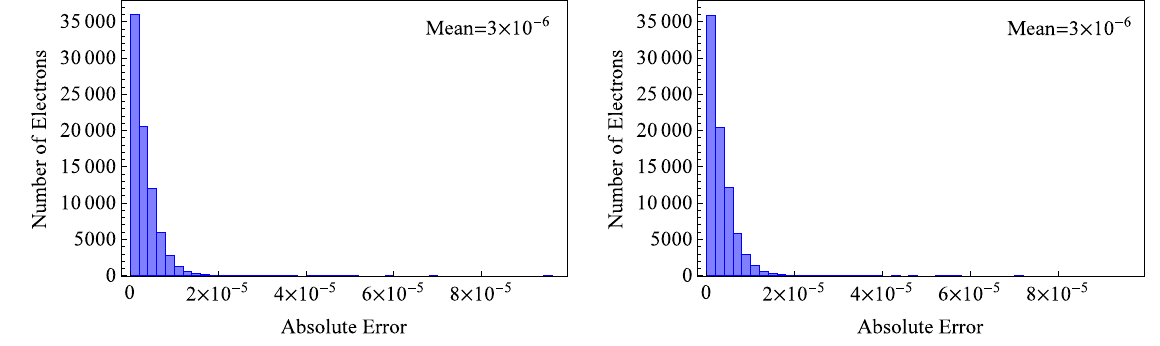
electrons.FIG. 10. The absolute errors in the x coordinates (left) and in the y coordinates (right) of the electrons in the beamlets simulations by PHAD compared to the standalone Simò integrator. The mean of the absolute errors is on the order of 10 − 6